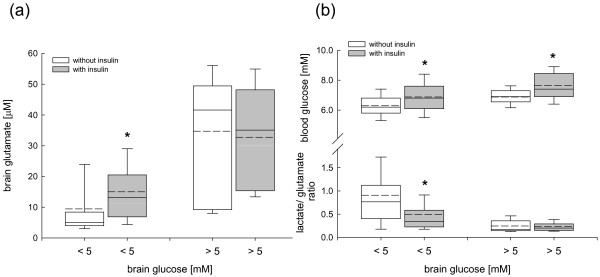
Changes in (a) brain glutamate, (b) calculated brain lactate-to-glutamate ratio, and arterial blood glucose determined by cerebral microdialysis investigating the influence of time points with insulin (grey box plots) and without insulin (white box plots) administration in pre-defined brain glucose clusters. At brain glucose levels ≤ 5 mM brain glutamate was significantly increased under the influence of insulin compared with time points without insulin administration (*P < 0.001, Mann-Whitney test). In parallel lactate-to-glutamate was significantly decreased (*P < 0.001, Mann-Whitney test). At brain glucose levels >5 mM insulin did not influence brain glutamate or lactate-to-glutamate ratio. Whenever insulin was administered, arterial blood glucose was significantly increased compared with time points insulin was not given (*P < 0.001, Mann-Whitney test).